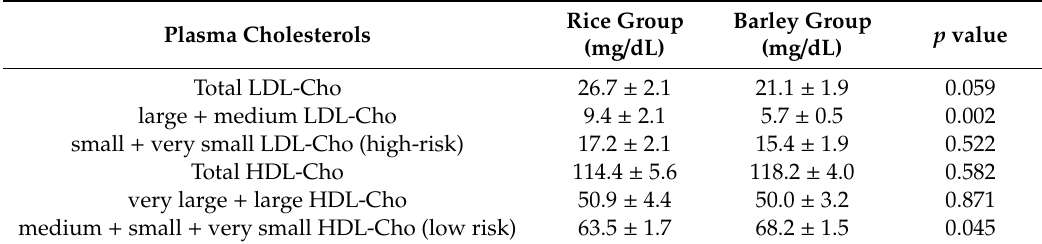
Table 2. Plasma cholesterol